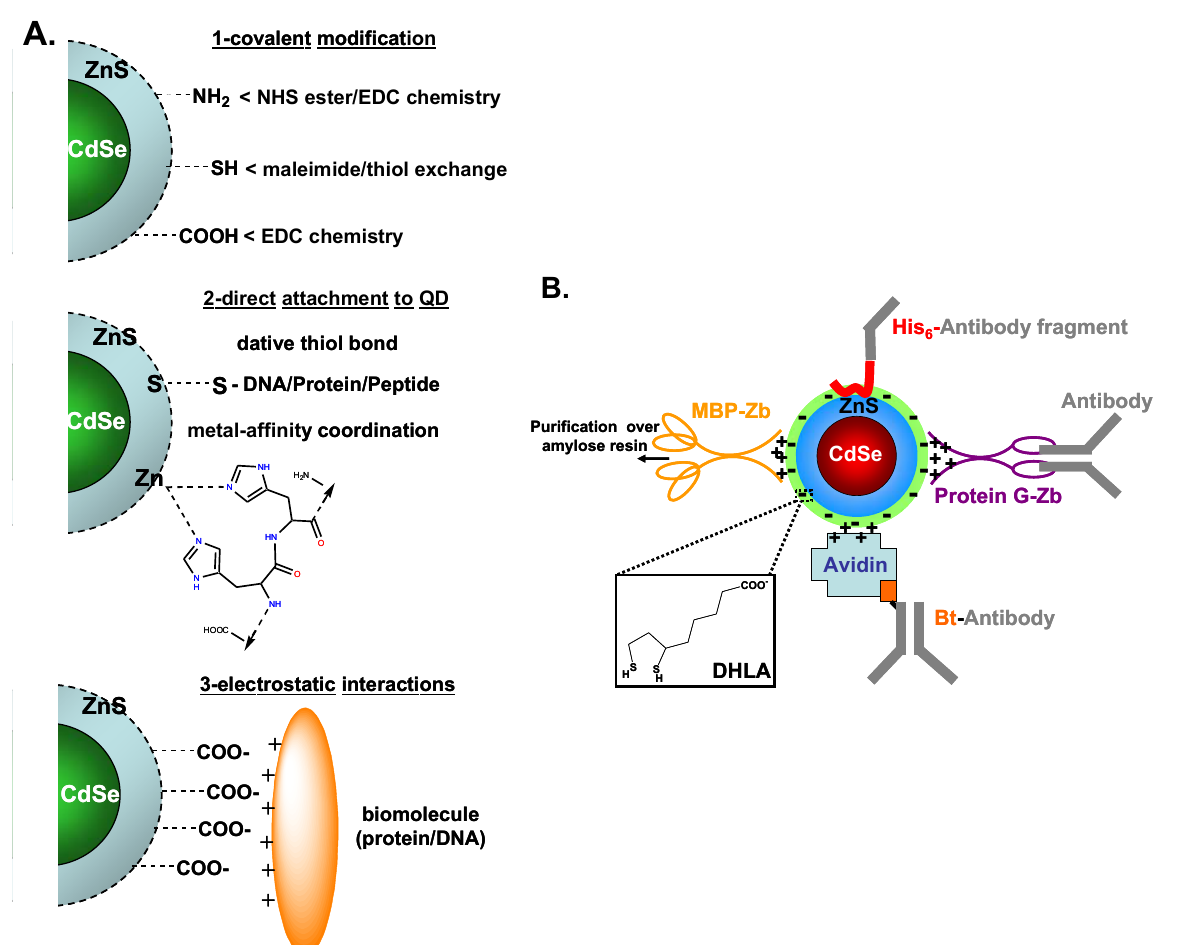
Figure 2. Methods of Conjugating Biomolecules to